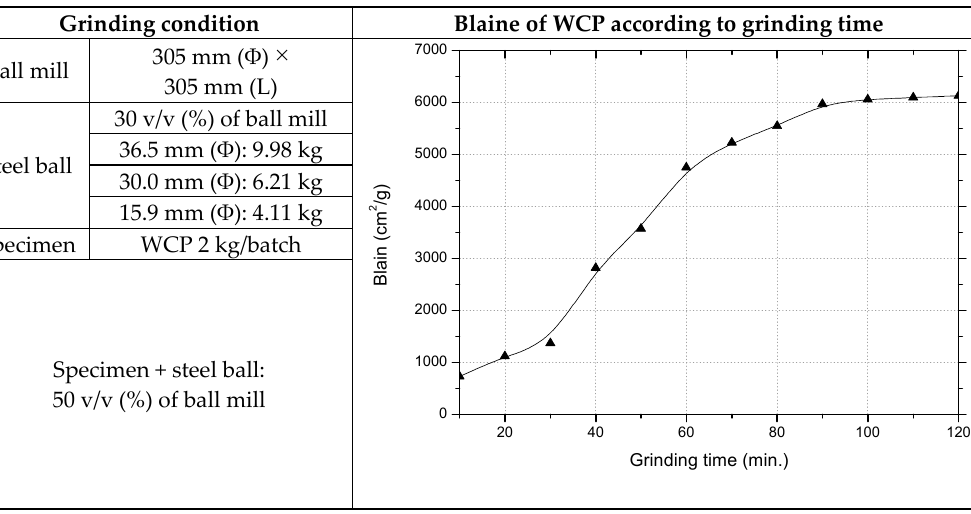
Figure 3. Waste concrete powder SEM images.